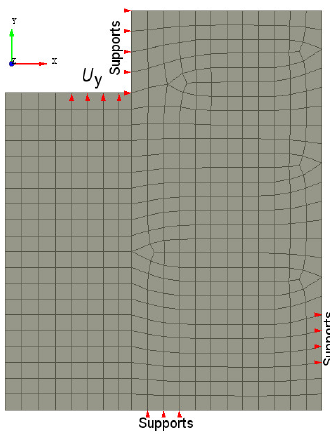
by 2 . 5 mm quadrilaterals aligned with the specimen longitudinal direction and lamina.